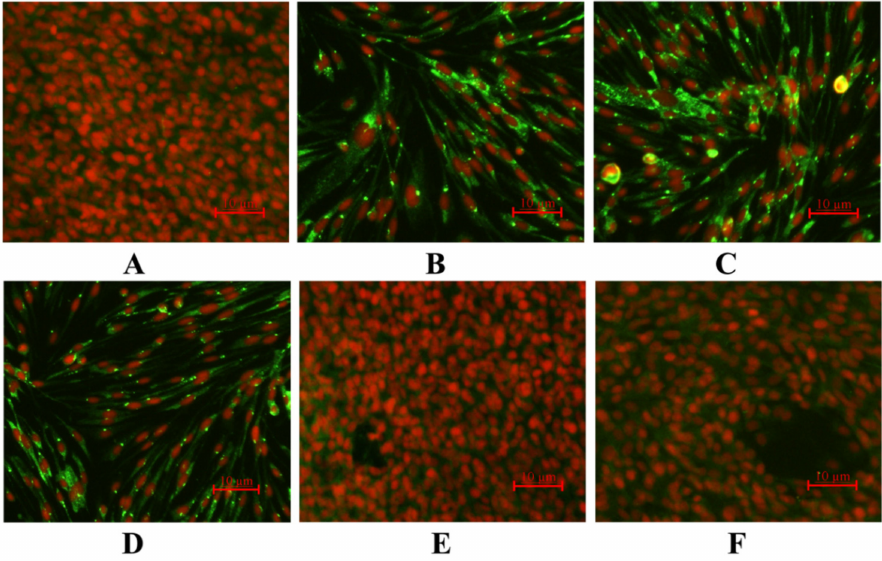
Figure 3. Indirect immunofluorescence assays for infected CIK cells. ( A ) Uninfected cells and cells infected with ( B ) GCRV-GZ1208, ( C ) GCRV-873, ( D ) GSRV, ( E ) GCRV-HZ08 (genotype II), and ( F ) HDGRV (genotype